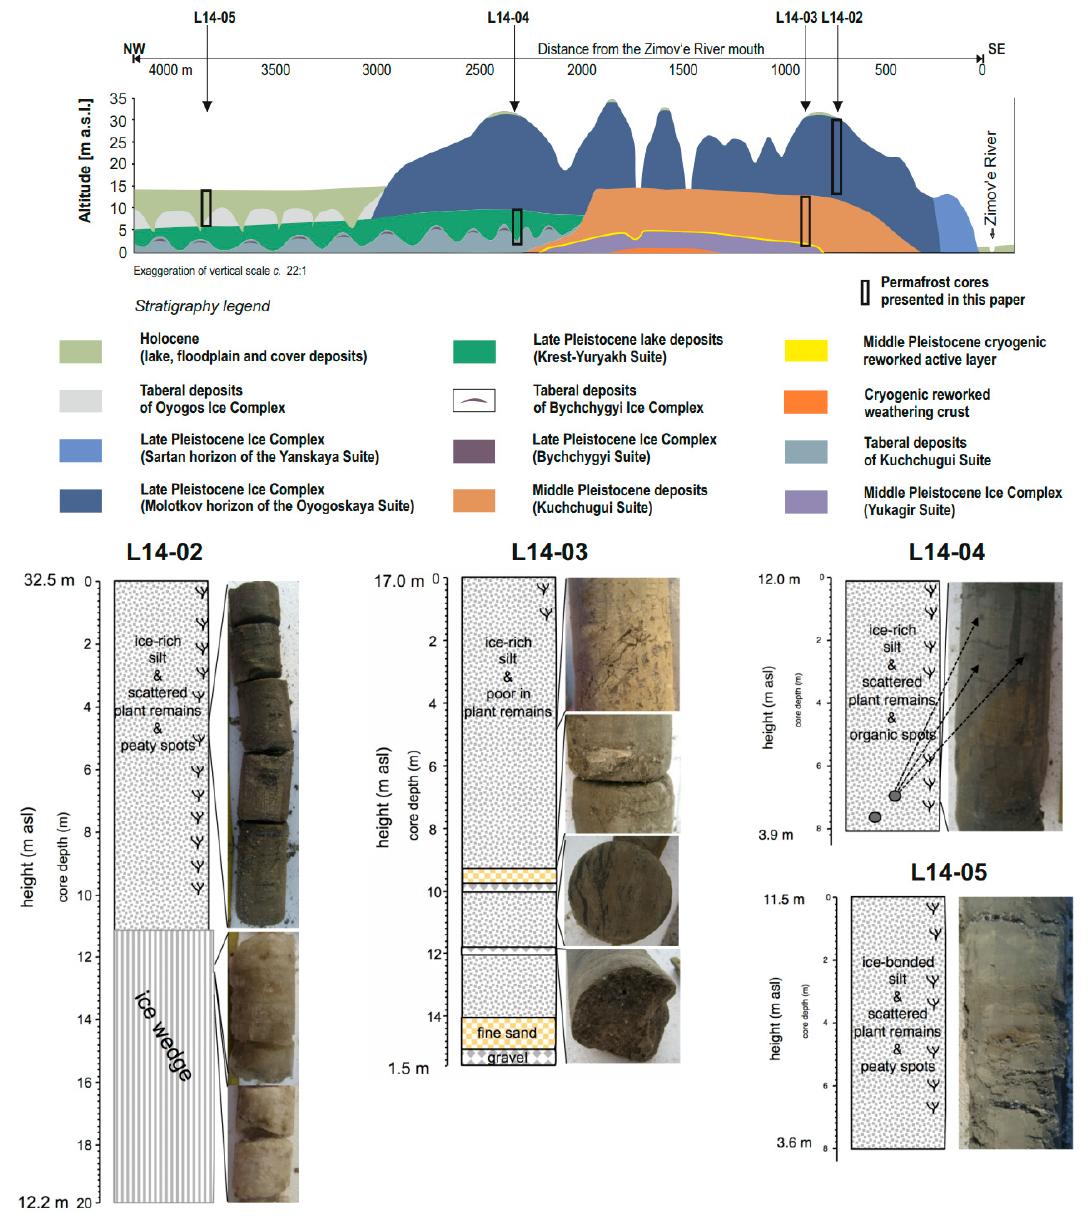
Figure 2. Quaternary stratigraphy of the southern coast of Bol’shoy Lyakhovsky Island with core positions indicated by black boxes [48] (modified after [4,8,25]). The lower panel shows the schematic core recoveries with photographic examples [48].